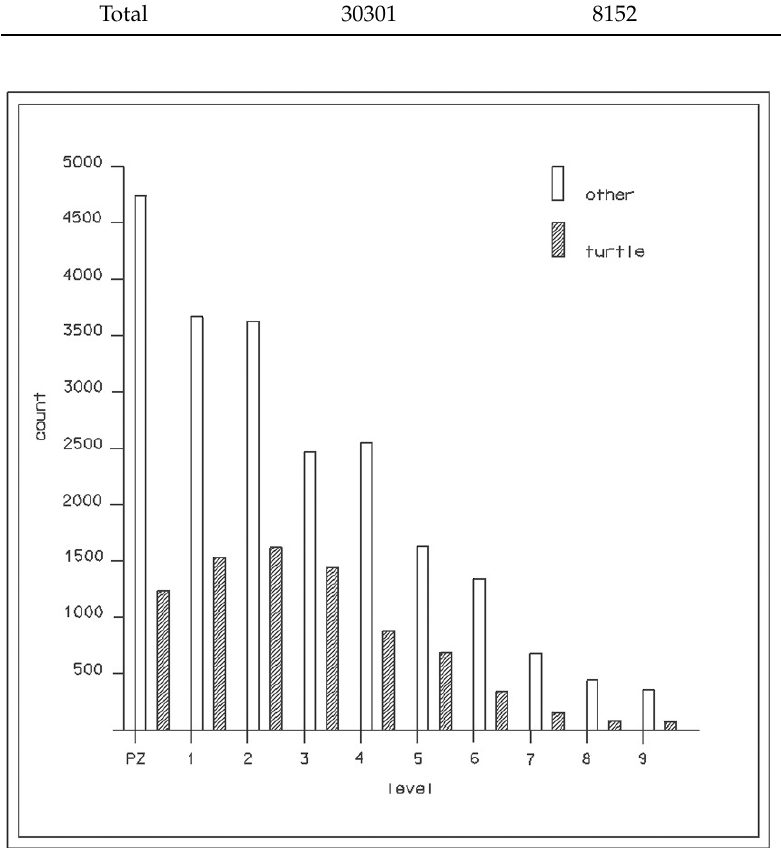
Figure 3. Distribution of bone fragments by level. Table 2. Total bone fragments and turtle by level.